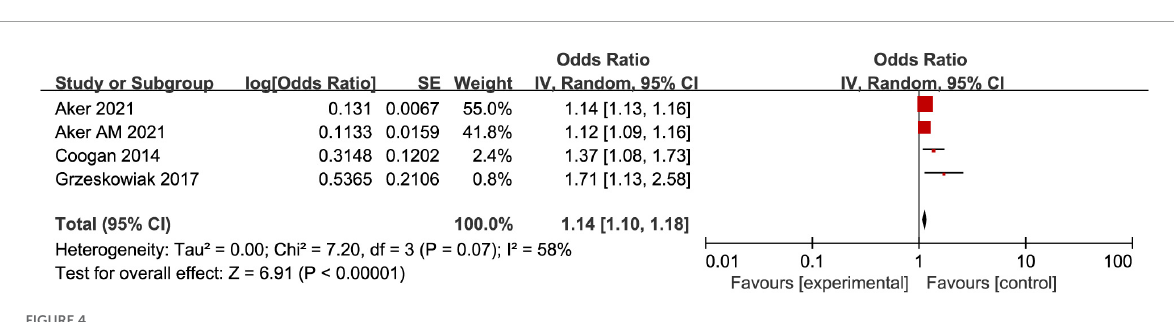
FIGURE4 Forest map of association meta-analysis between AD and MD—Only studies of the same disease type were